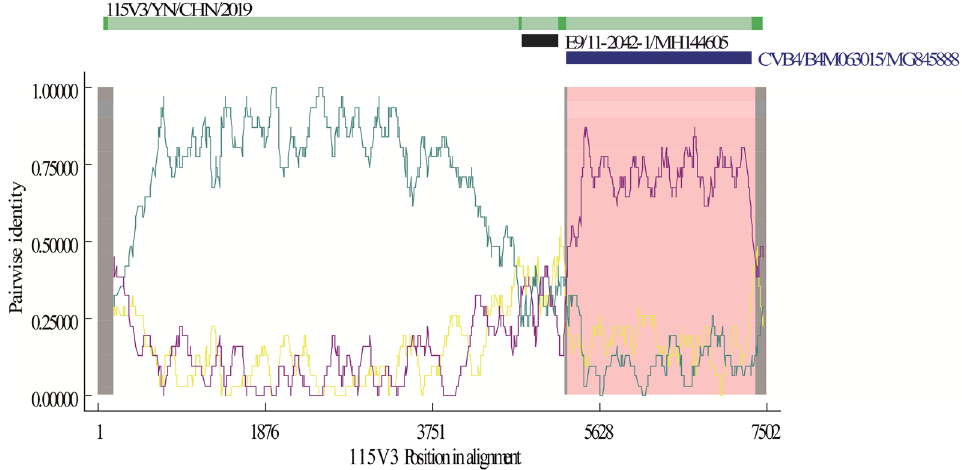
Figure 4. RDP4 software analysis of strain 115V3 with closely related strains. Seven algorithms were used for recombination analysis: RDP, GENECONV, BootScan, Maxchi, Chimaera, SiScan, and 3Seq.